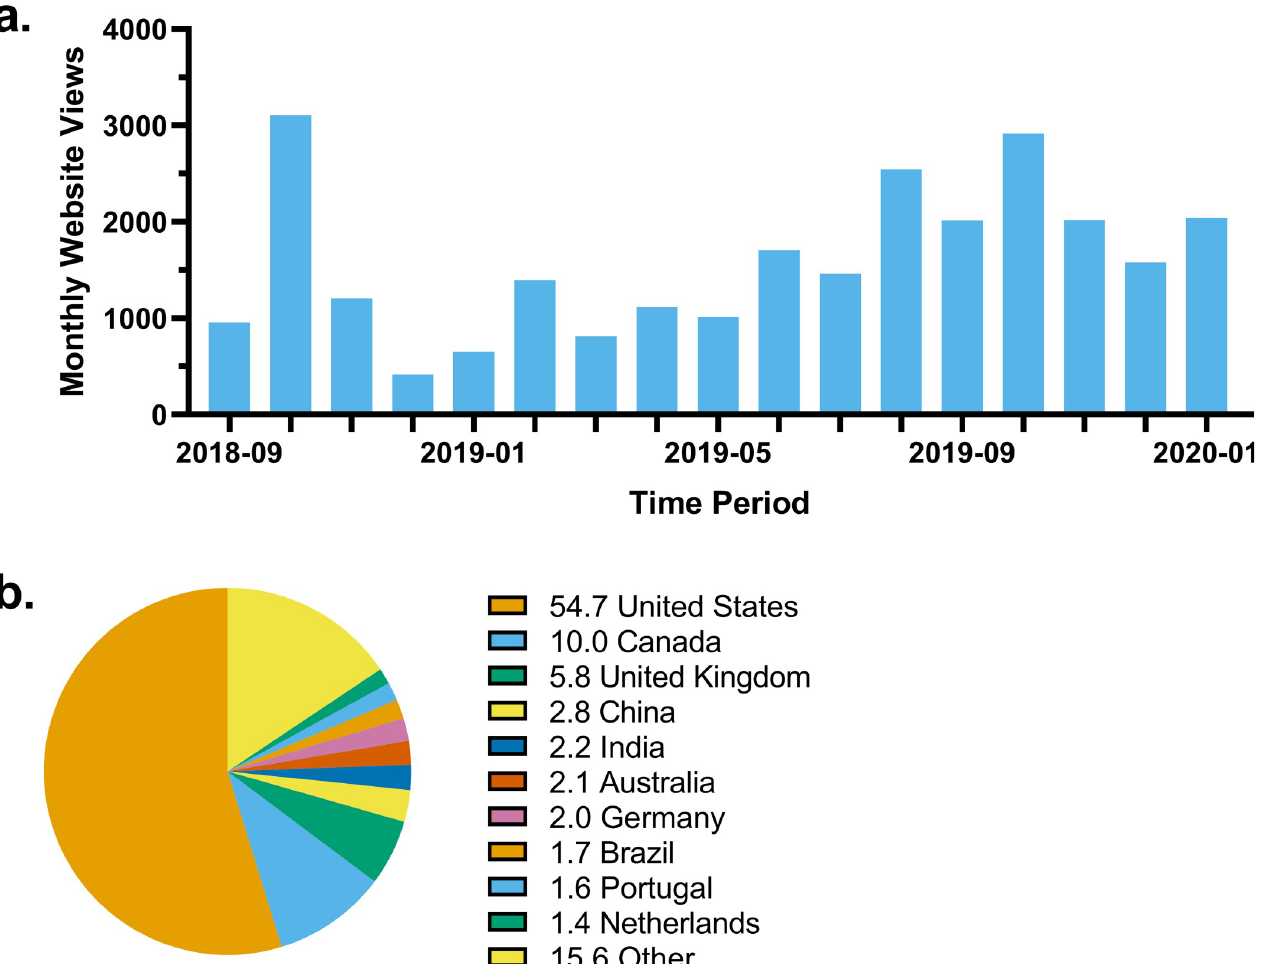
Fig 1. SCAsource website visit statistics. (A) Total website views of SCAsource.net per month. Time period ranging from September 2018 to January 2020. (B) Country of origin of SCAsource viewers. Top ten individual values displayed with representative percentages.